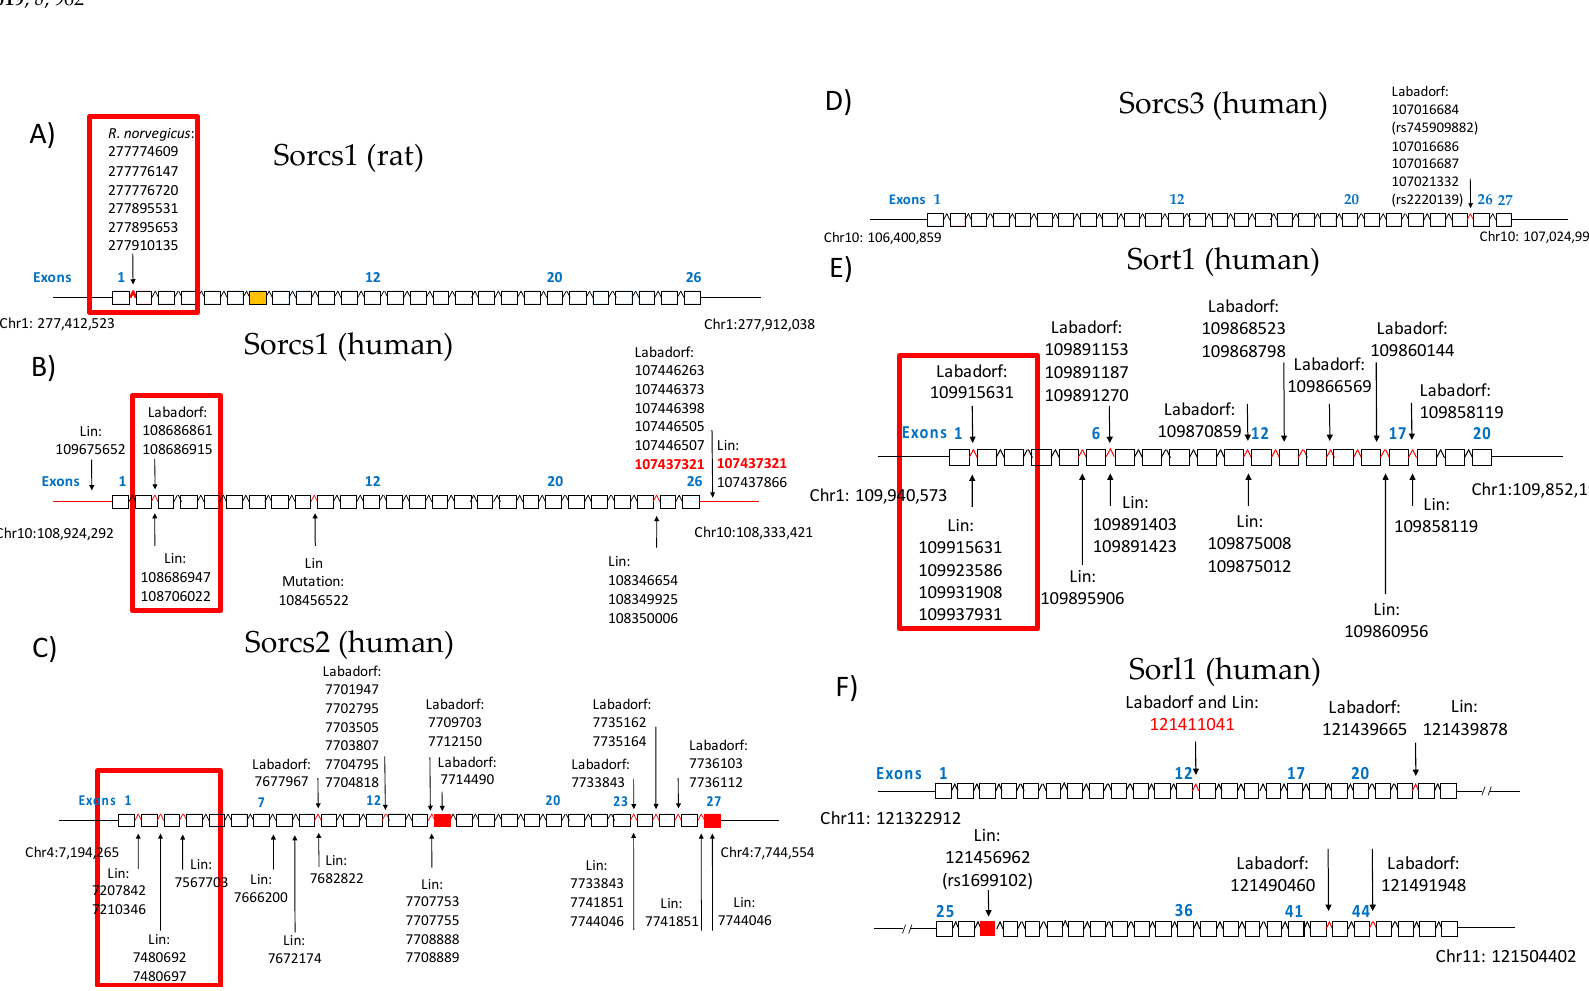
Figure 1. Organization of sortilins genomic regions showing SNPs detected by the GWAS / GATK pipeline across introns and exons. The dataset of the identification is indicated. ( A ) SORCS1 gene organization in R. norvegicus . ( B ) SORCS1 gene organization in human. ( C ) SORCS2 gene organization in human. ( D ) SORCS3 gene organization in human. ( E ) SORT1 gene organization in human. ( F ) SORL1 gene organization in human. Mutations inside the red squares represent SNPs in introns between exons that encode the VPS10P domain (Reitz 2013). Exons were indicated with their numbers in blue for identification.